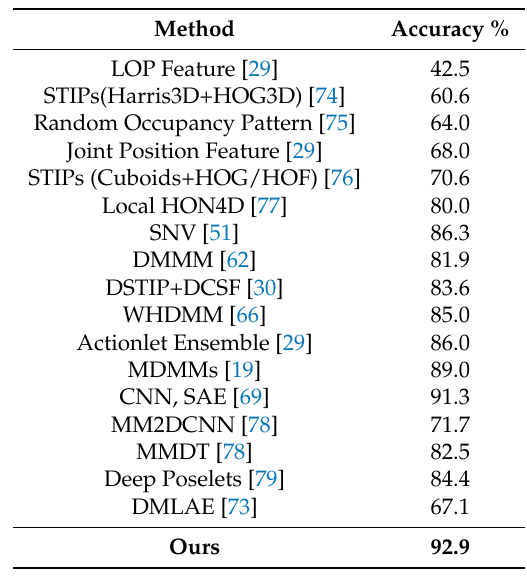
Table 15. Comparison of our overall proposed method in comparison with state-of-the-art approaches. Results are for the MSR daily activity 3D dataset